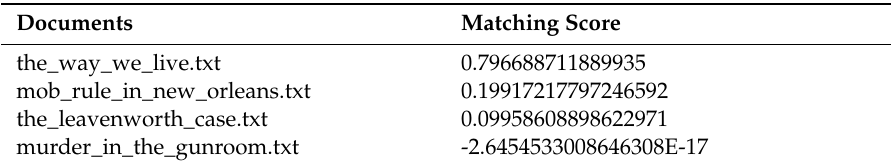
Table 2. Top Docs for TermQuery: Prison, Kill, Destroy.